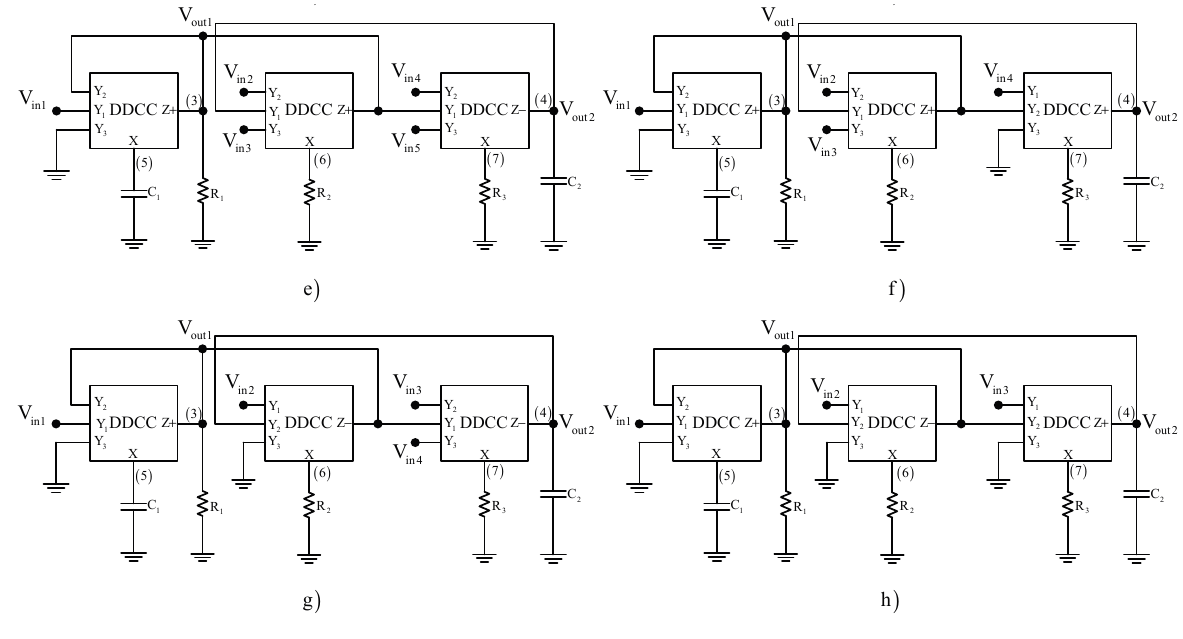
Figure 5. The practical configuration of type-A